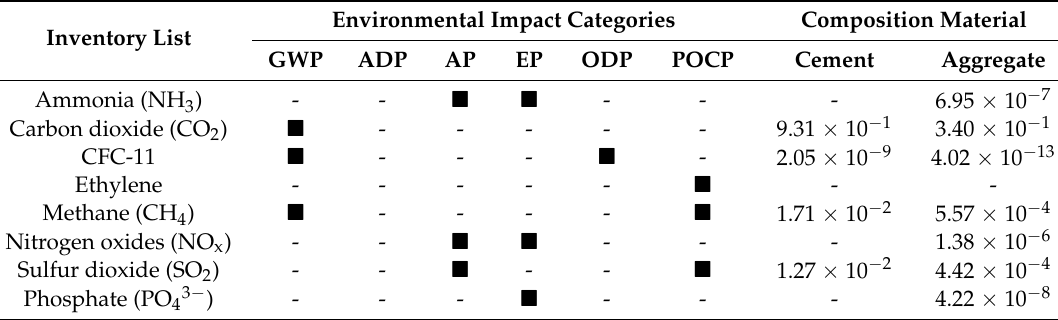
Table 3. Classification value of Composition material for concrete.